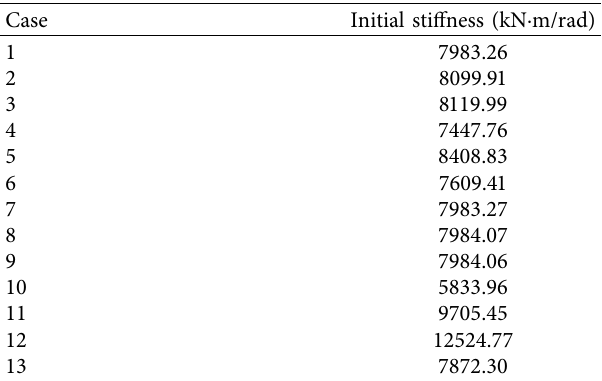
Figure 5: The stiffness degradation of moment-rotation curve. Table 2: Initial